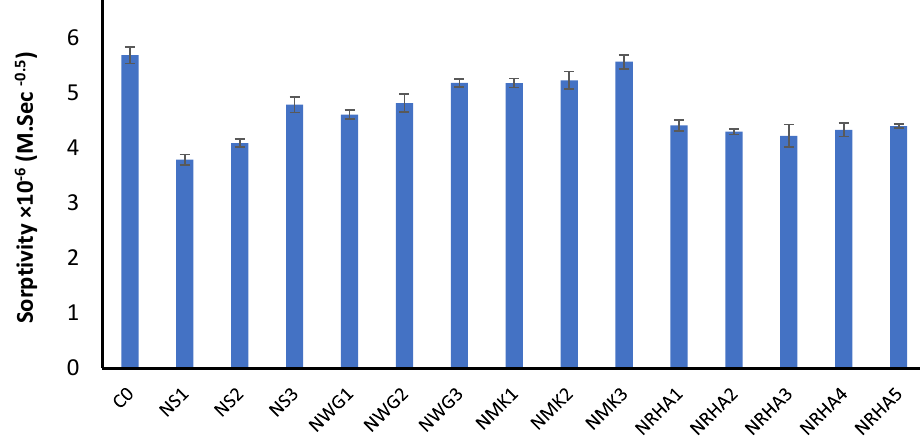
Figure 8. Experimental results of sorptivity of different concrete mixes at 28 days.